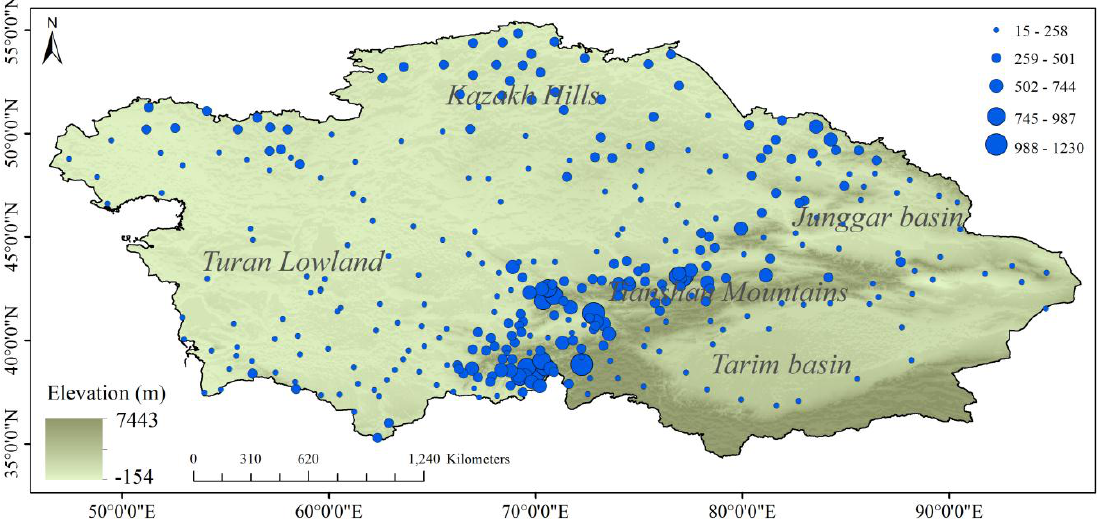
Figure 2. The distribution of the mean annual precipitation (mm) based on meteorological stations in Central Asia.